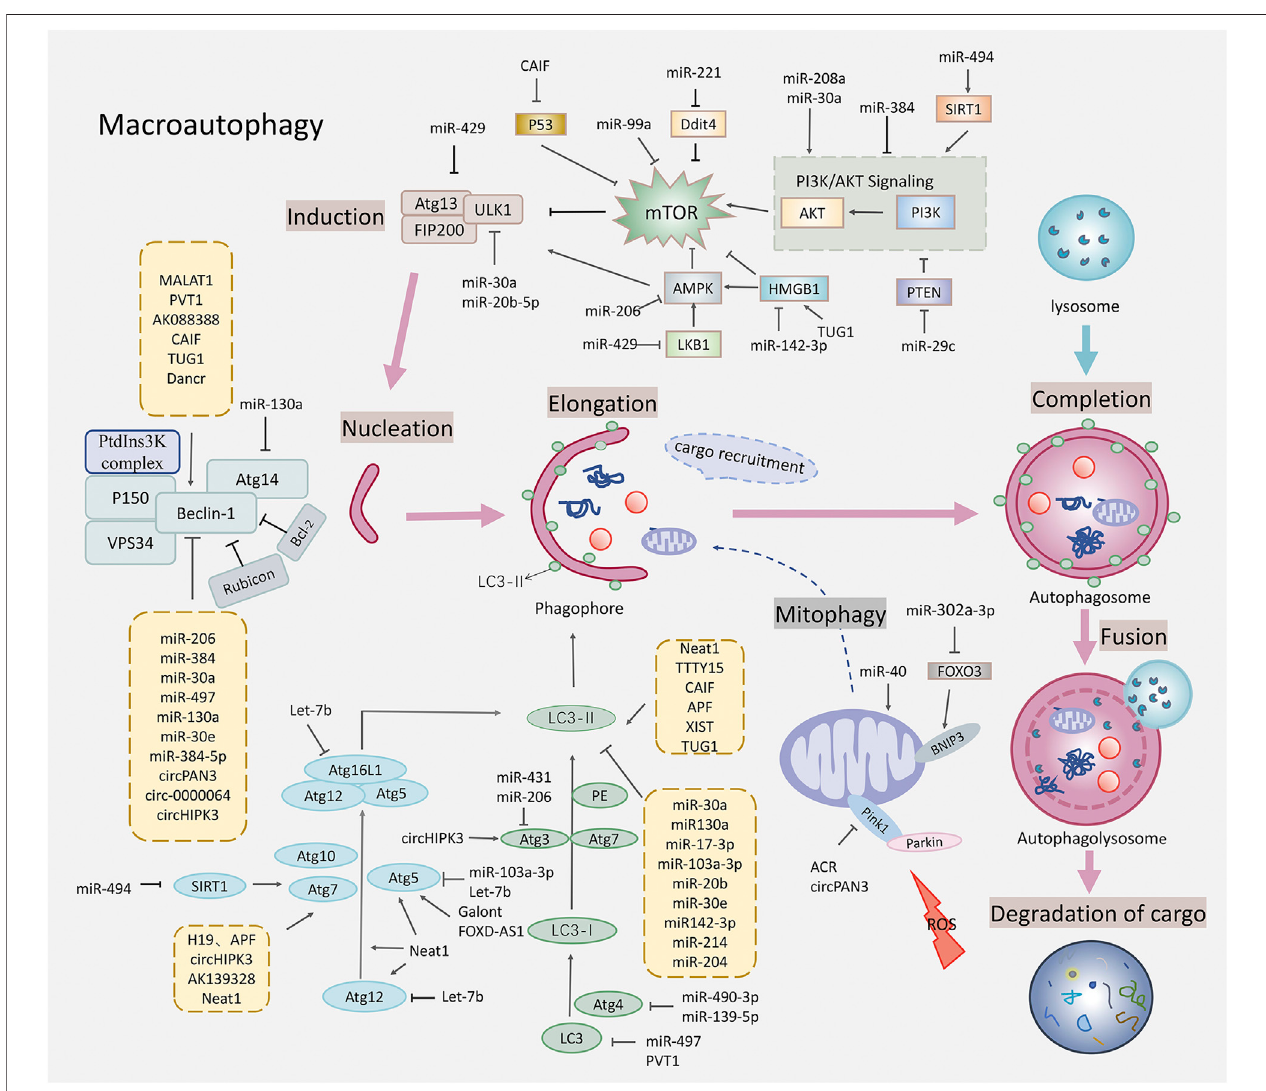
FIGURE 1 | Schematic diagram of autophagy regulated by the non-coding RNAs in the myocardial ischemia-reperfusion injury. This fi gure shows that the non- coding RNAs affected the various stages of autophagy, regulating the targets related to the macroautophagy including the mTOR related signaling pathways, the ULK1 complexthatiscloselyrelatedtotheBeclin-1,thevesiclenucleationpromotedbythePtdIns3Kcomplex,theautophagosomeextensionpromotedbytwoubiquitylation- like conjugation systems, the fusion of the autophagosomes with lysosomes, and mitophagy. Speci fi c gene targets include the AMPK, mTOR, ULK1, Beclin-1, Atg5, Atg7, Atg3, Atg12, LC3, and Pink1.